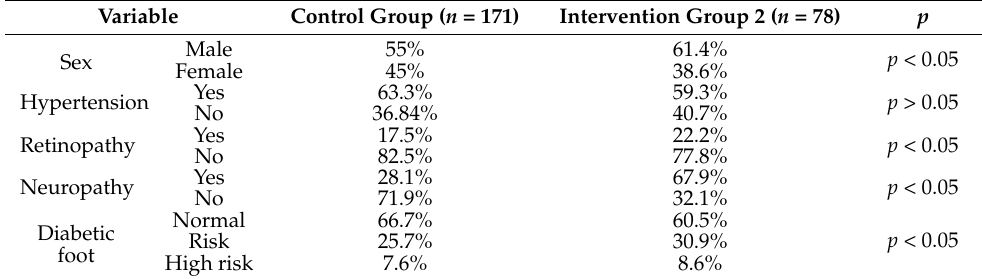
Table 1. Characteristics at baseline.